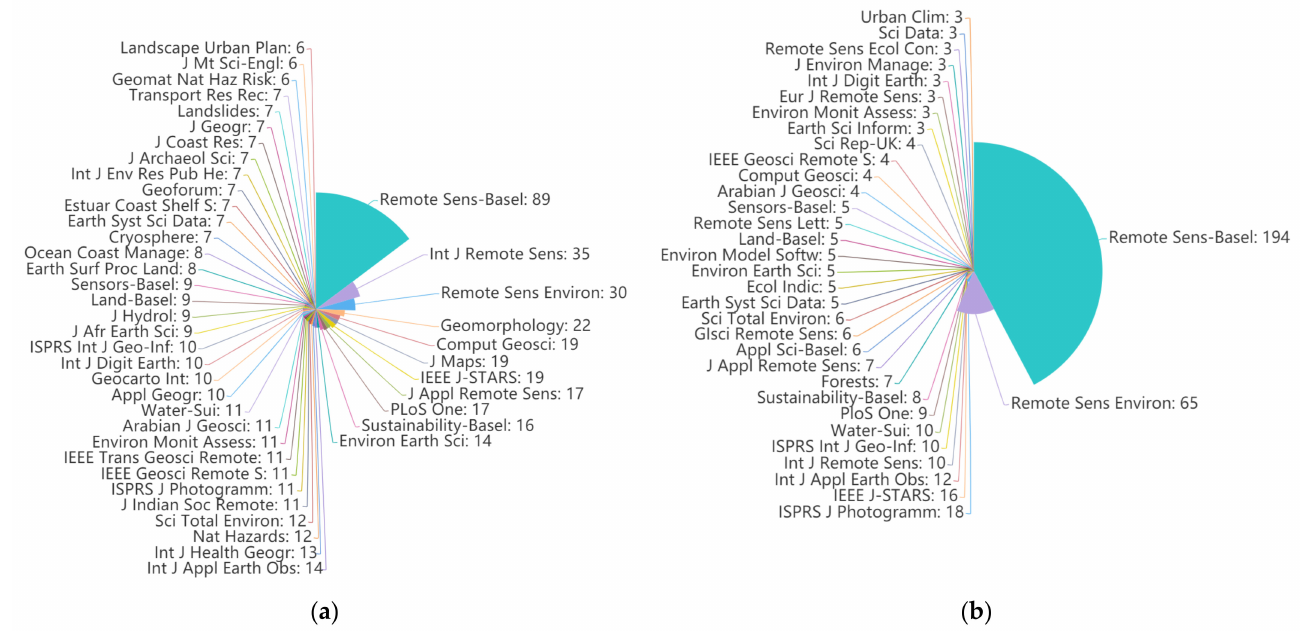
Figure 2. Journals in which papers related to ( a ) GE and ( b ) GEE were